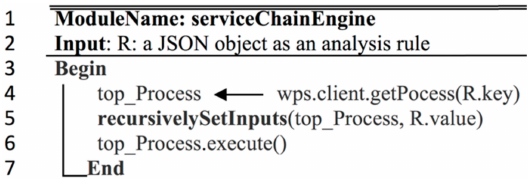
Figure 6. Algorithm for generating and executing a service chain.